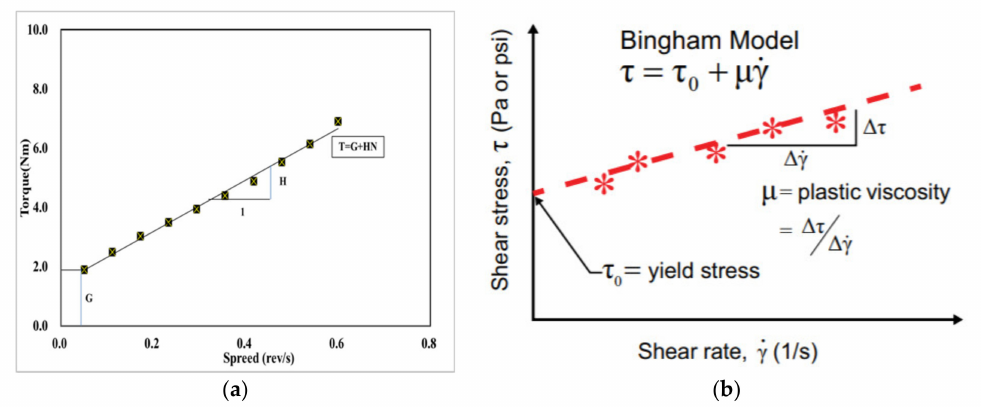
Figure 6. ( a ) Relative values for the ICAR rheometer, ( b ) absolute values calculated by solver of ICAR-rheometer, example of the concrete rheology test results using ICAR rheometer. T =